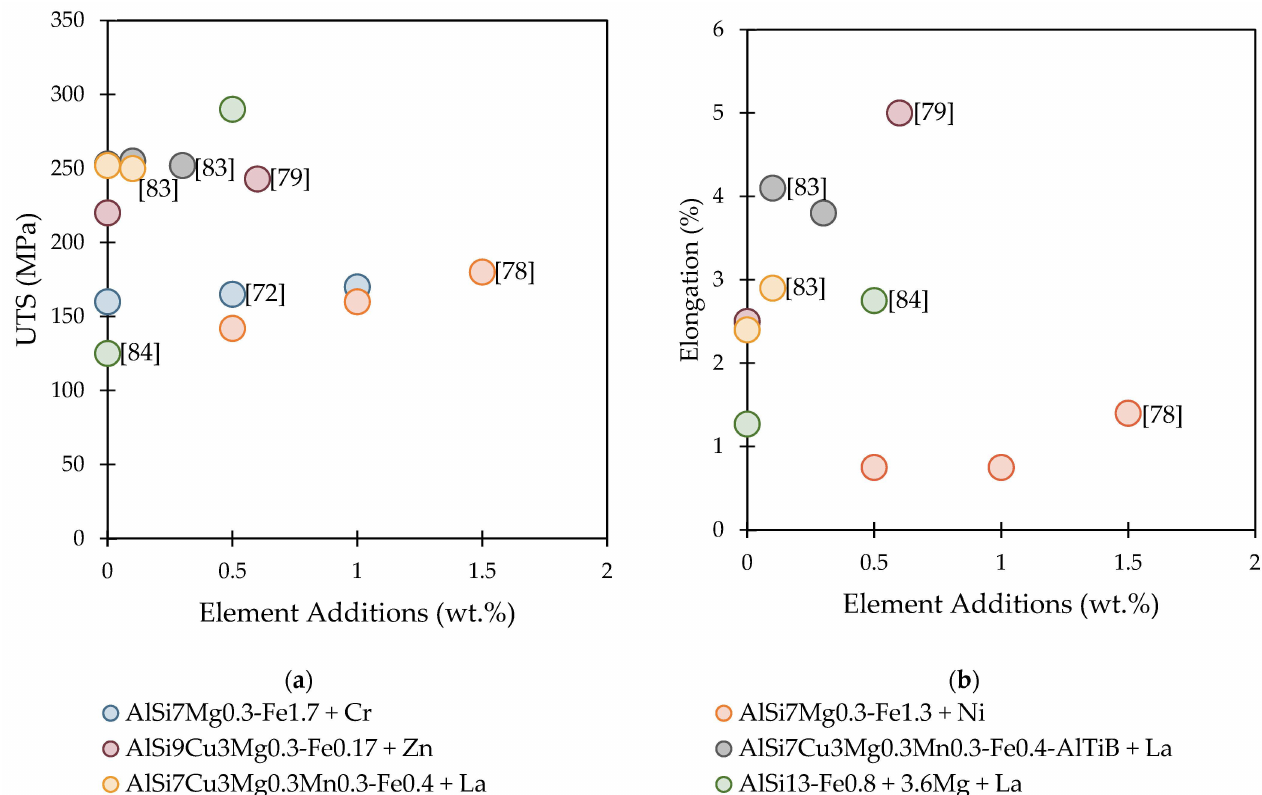
Figure 9. A summary of the improvements in mechanical properties obtained from the researches presented in Table 4: ( a ) UTS and ( b )